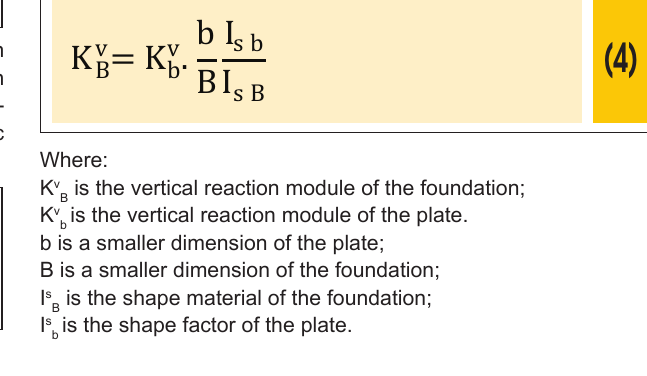
v Table 3.1 – Values of K